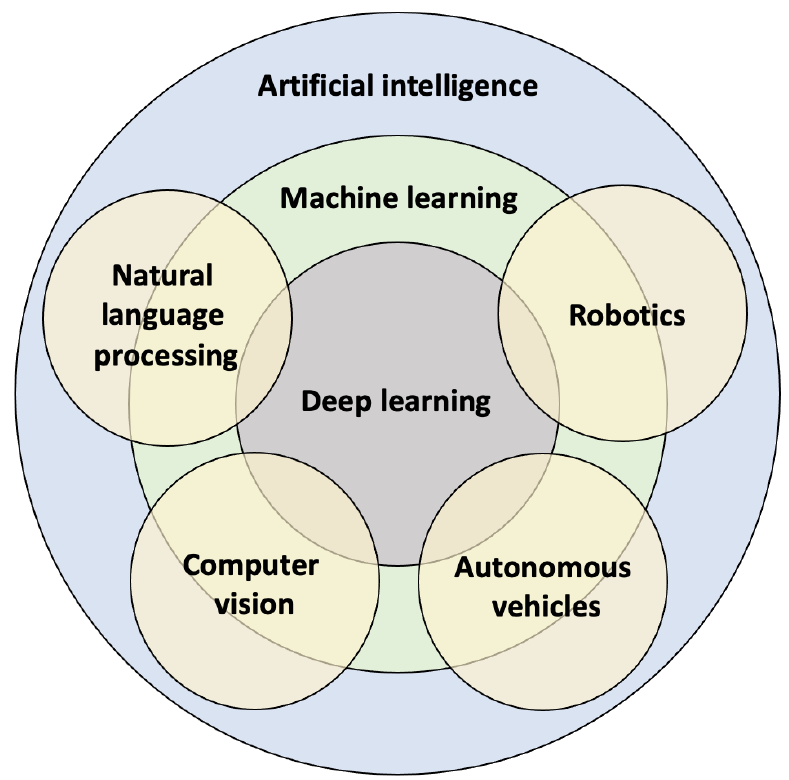
Figure 1. Artificial intelligence and its subfields .